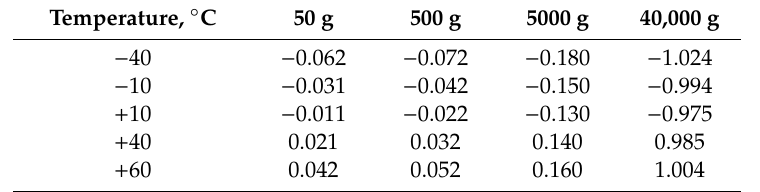
Table 4. Deformation of the console when heating or cooling and acceleration (µm).